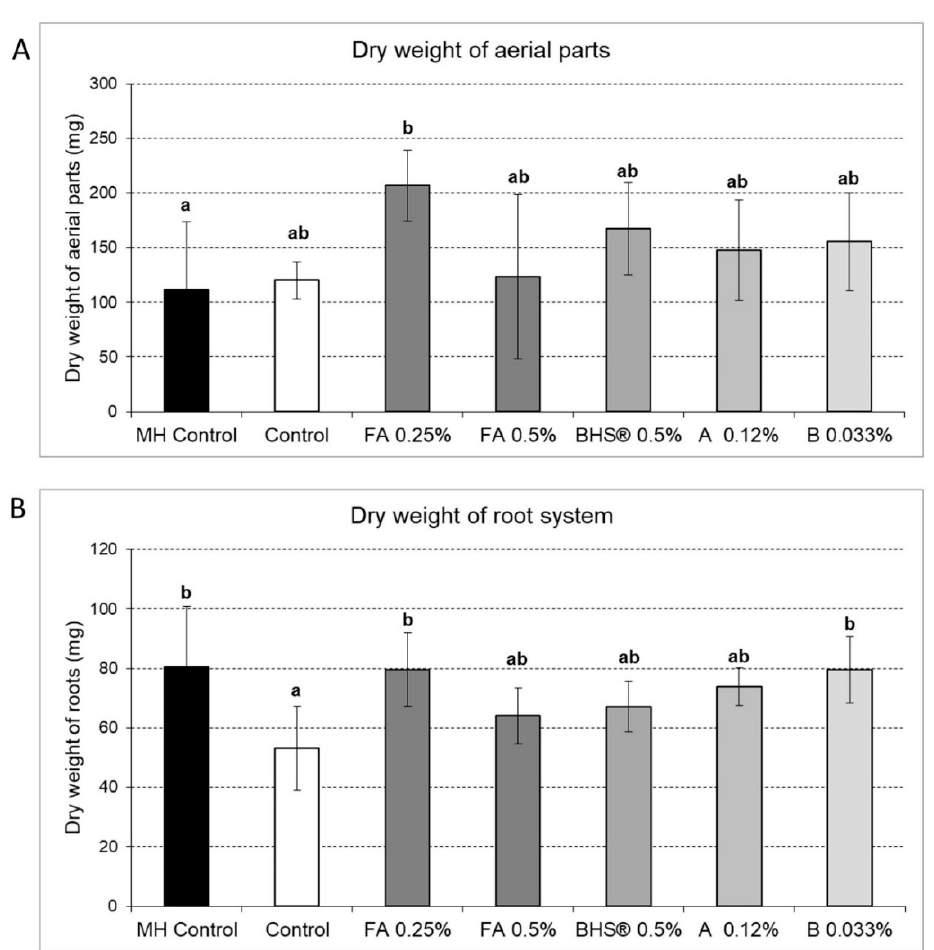
Figure 3. ( A , B ): Dry weight measurement of aerial parts ( A ) and roots ( B ) of Vicia faba after 56 h of experiment: non-exposed (Control) or exposed to 10 − 5 M Maleic hydrazide (MH Control), or to different commercial products: fulvic acids at 0.25% (FA 0.25%) or 0.5% (FA 0.5%), biomimetic humic substances (BHS ® 0.5%), or products A and B. (Histograms marked with the same letter are not statistically different at p < 0.05).